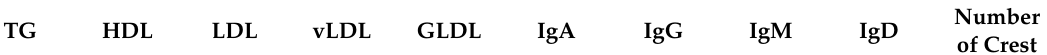
Table 7. Correlation analysis of crested-cushion number with lipoprotein and immunoglobulin in serum biochemical